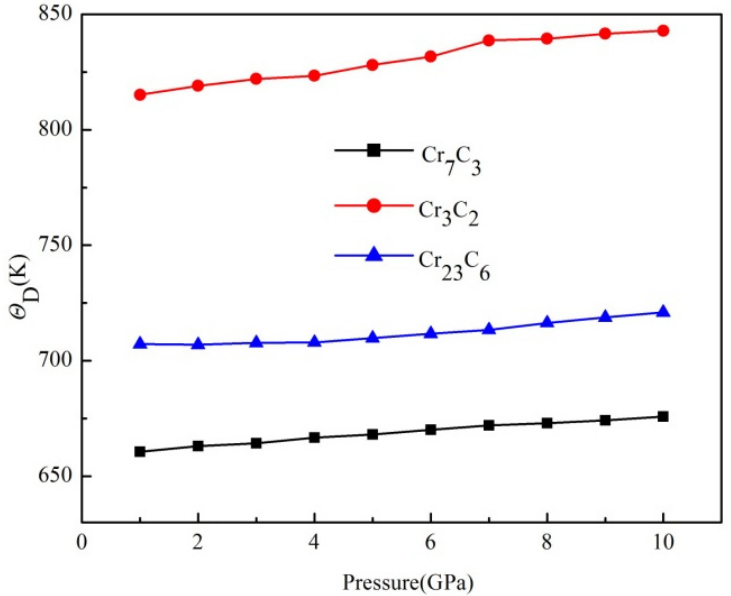
Figure 11. The variation in anisotropic hardness with respect to applied pressure.